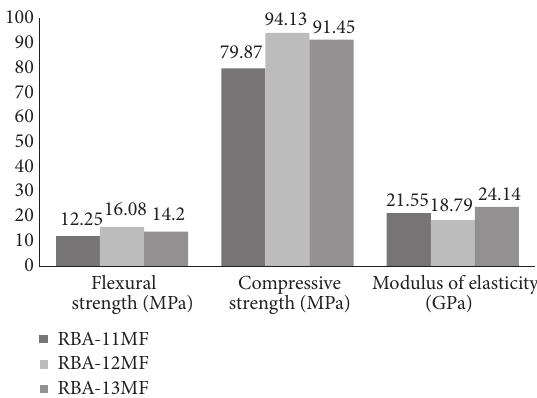
Figure 9: Comparison of the obtained mechanical properties from RBA-11MF, RBA-12MF, and RBA-13MF.